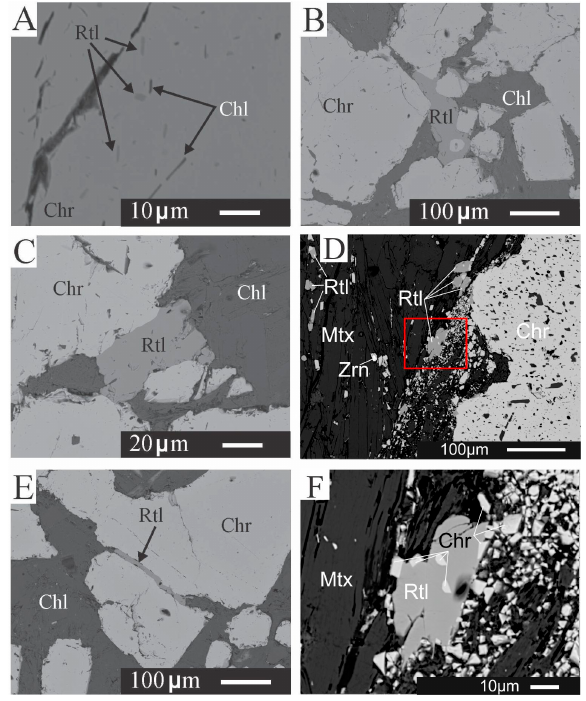
Figure 7. BSE images of different forms of occurrence of rutile in the Cedrolina chromitite ( A ) Plenty of prismatic micro inclusions (<10 µ m) of rutile and chlorite in chromite; ( B ) Large anhedral/irregular rutile crystal in the chromite/chlorite contact, also exhibiting an included chromite fragment; ( C ) Anhedral rutile crystal observed in the chromite/matrix interface; ( D ) Rutile porphyroblasts/prisms concordantly oriented with the metamorphic foliation (Fn is vertical in the photo) and often presenting inclusions of chromite fragments, situated near the edge of a large Cr-spinel aggregate. Area of red rectangle zoomed in (F); ( E ) Elongated and anomalously large rutile crystal (>250 µ m) that fills a fracture between two large chromite fragments; ( F ) Zoomed area of red rectangle in (D) displaying a rutile porphyroblast with abundant micro-inclusions of chromite fragments. Abbreviations: Chr = chromite; Chl = chlorite; Mtx = matrix; Rtl = rutile; Zrn = zircon. Table 3. Selection of representative electron microprobe trace element analyses of rutile from Cedrolina chromitite (ppm).